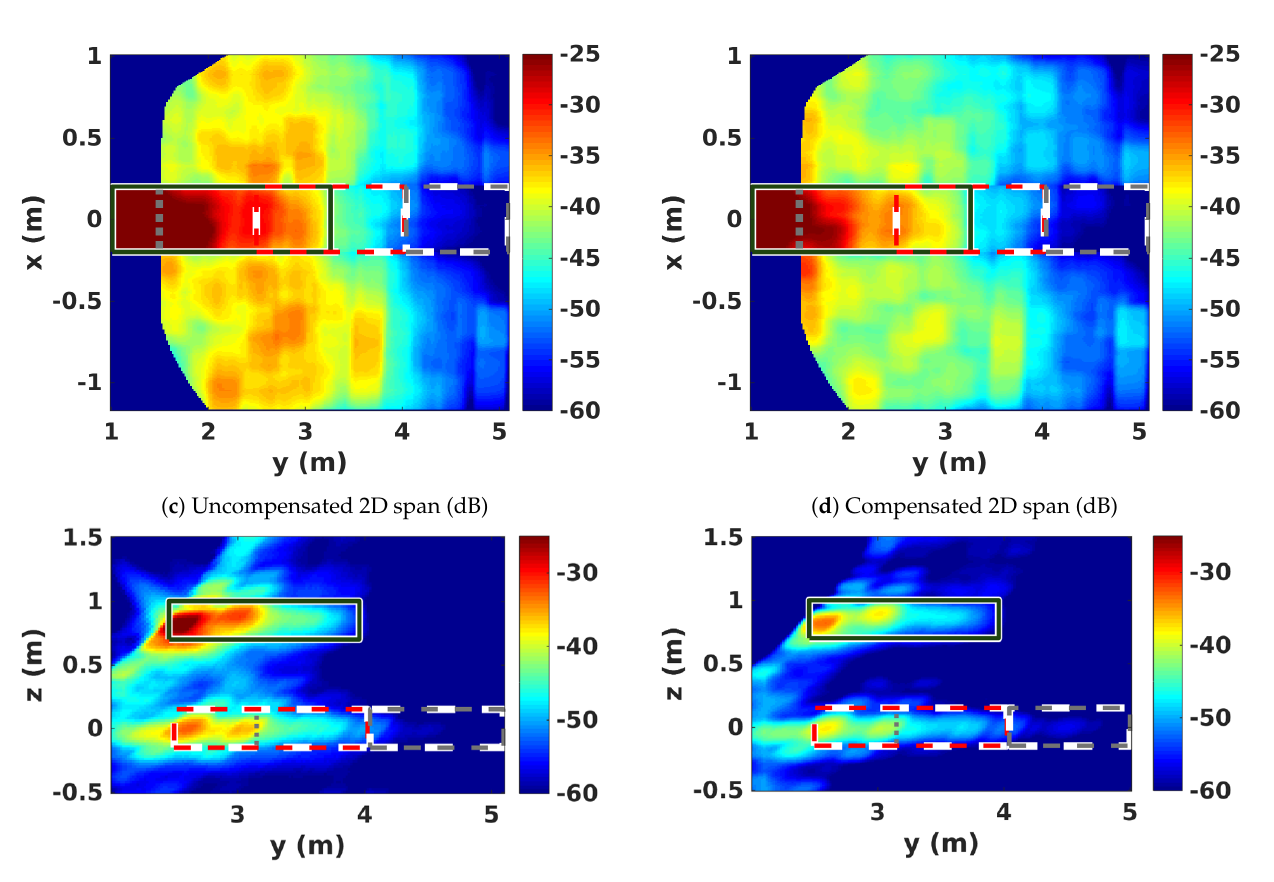
Figure 6. Antenna pattern and image correction in 2D and 3D SAR imaging.